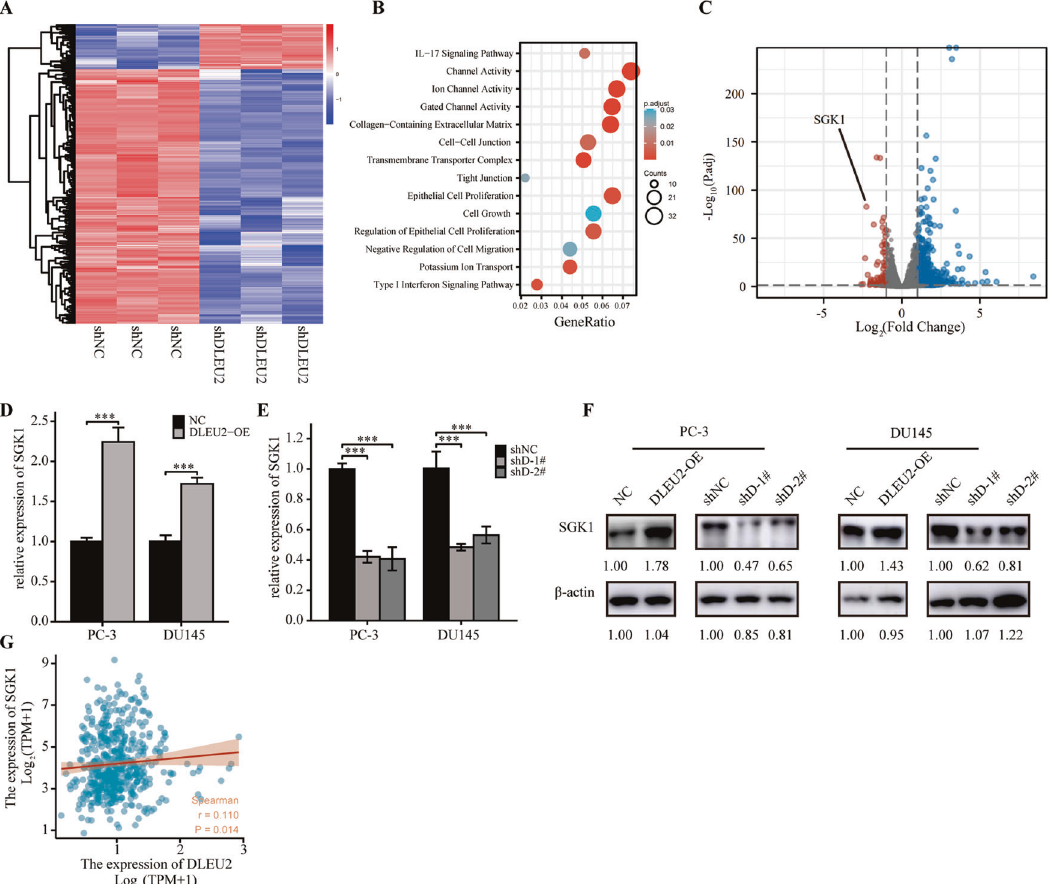
Fig. 3 DLEU2 expression was positively correlated with SGK1 expression. A Heatmap illustrating the differentially expressed genes (DEGs) in PC-3 cells between shNC group and DLEU2 knockdown group. B GO and KEGG enrichment analysis of DEGs. C Volcano map showing the DEGs in PC-3 cells between shNC group and shDLEU2 group. D , E RT-qPCR result showing the expression of SGK1 PC-3 and DU145 cells. F Western blotting analysis of SGK1 expression in PC-3 and DU145 cells. G Correlation between SGK1 expression and DLEU2 expression in TCGA database using spearman analysis. Data were indicated as mean ± SD, ns P ≥ 0.05, * P < 0.05, ** P < 0.01, *** P <